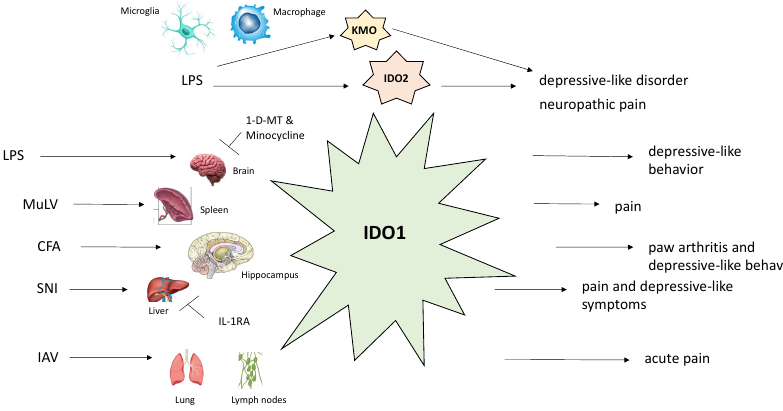
Figure 2. Schematic description of the e ff ects of di ff erent stimuli on biological functions of major kynurenine pathway enzymes (IDO-1, IDO-2, KMO). Abbreviations: CFA, Complete Freund’s Adjuvant; IAV, influenza A virus; IDO-1, indoleamine 2,3-dioxygenase 1; IDO-2, indoleamine 2,3-dioxygenase 2; KMO, kynurenine 3-monooxygenase; LPS, lipopolysaccharide; MuLV, murine leukemia retrovirus; SNI, spared nerve injury.